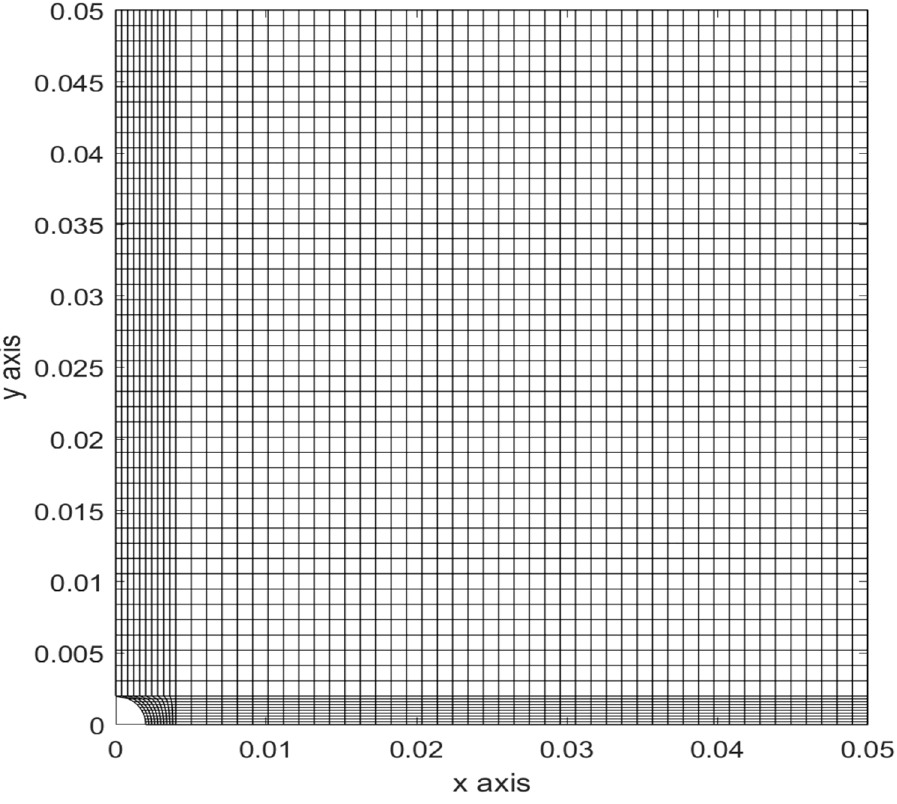
Figure 3. Finite element mesh of a quarter of a plate with a center hole.